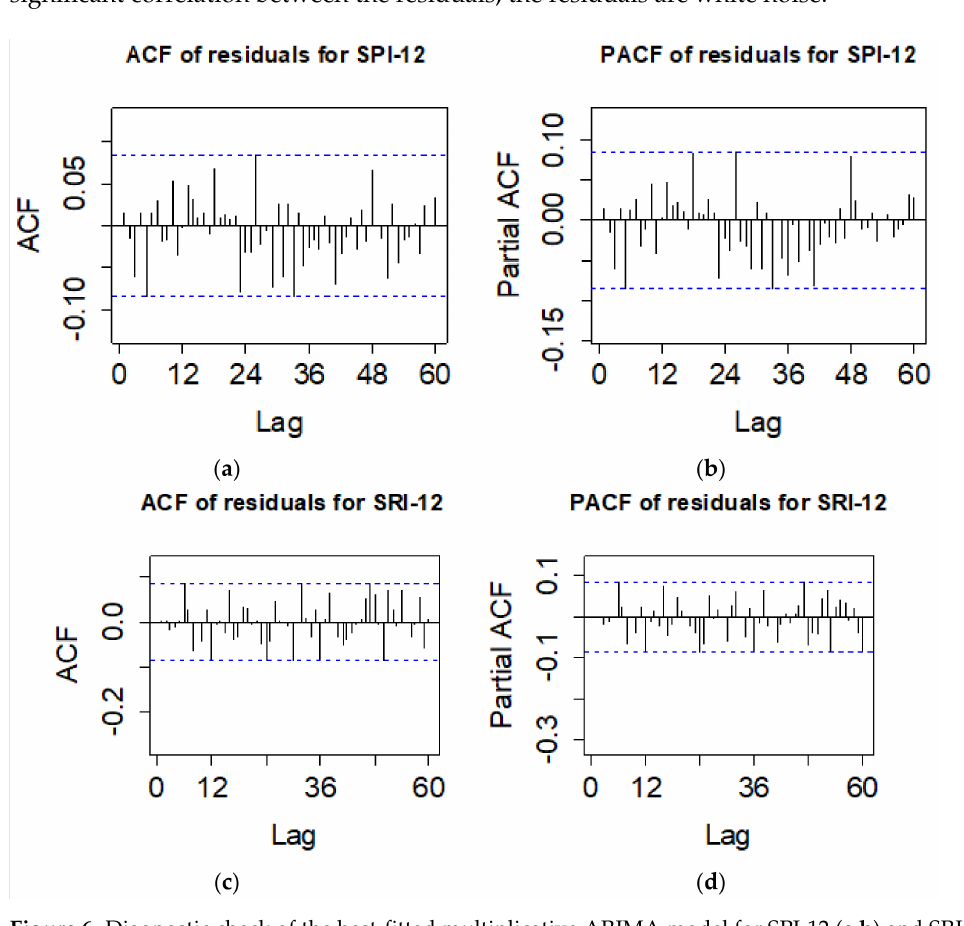
Figure 6. Diagnostic check of the best-fitted multiplicative ARIMA model for SPI-12 ( a , b ) and SRI-12 ( c , d ) time series for the Wadi Ouahrane